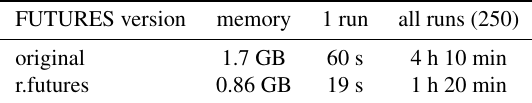
Table 2: Time and memory needed to run the simulations with the old version of FUTURES and the new r.futures implemented in GRASS GIS on a laptop with 64-bit Ubuntu 14.04 LTS, Intel Core i7-4760HQ @ 2.10GHz using 1 CPU and running on external hard